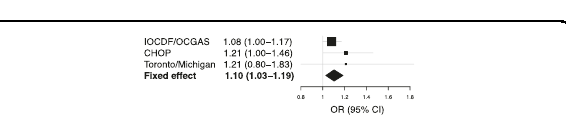
Fig. 3 Validation of locus in PTPRD in OCD samples. Forrest plot of genome-wide signi fi cant variant (rs7856850) across all the replication samples and sub-samples: (1) IOCDF/OCGAS (International Obsessive- Compulsive Disorder Foundation Collaborative and OCD Collaborative Genetics Association Studies samples), (2) CHOP (Philadelphia Neurodevelopmental Cohort (PNC) from the Children ’ s Hospital of Philadelphia, and (3) Michigan/Toronto OCD Imaging Genomics Study. Total cases: 3369; total controls: 8611. OR = odds